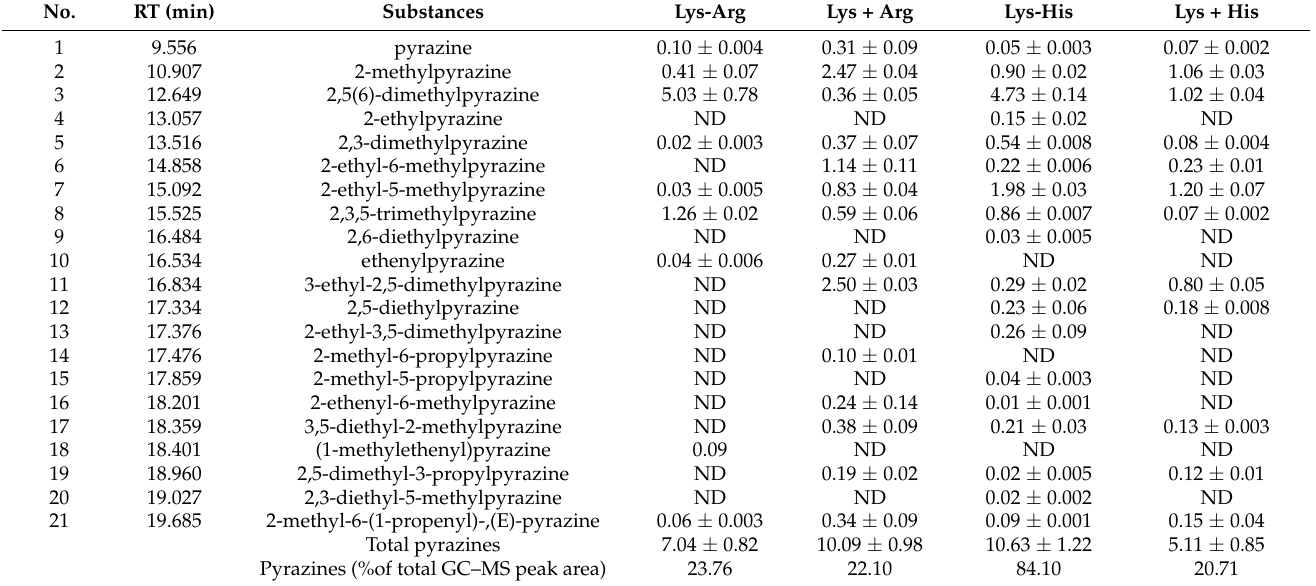
Table 2. Pyrazines contents ( µ g/g) in the model system (glucose with Lys-X dipeptides) and in the Control (Arg + Lys) and Control (His + Lys) ( p <